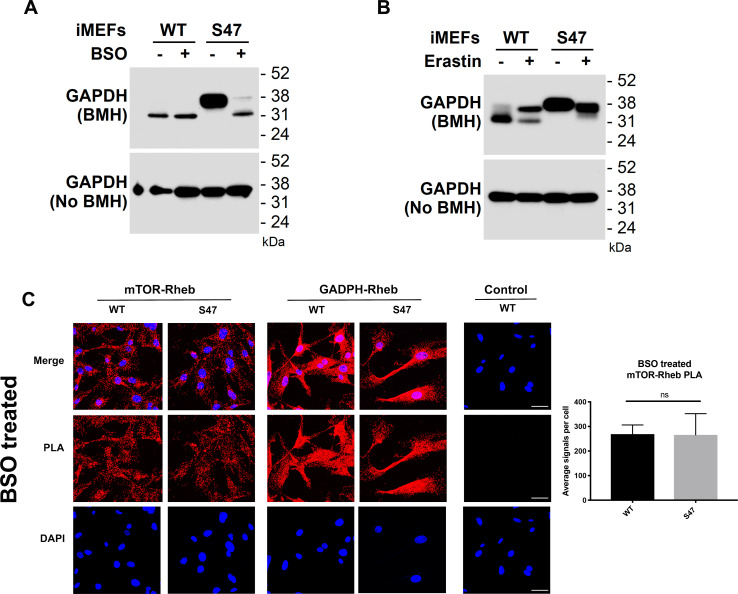
Glutathione depletion by BSO alters GAPDH cross-linking and the GAPDH-Rheb interaction.(A) WT and S47 cells were treated with PBS or 100 μM BSO for 24 hr. Lysates were prepared, treated with or without BMH, run on SDS-PAGE and detected by western blotting with a GAPDH antibody. (B) WT and S47 cells were treated with DMSO or 2 μM Erastin for 24 hr. Lysates were prepared, treated with or without BMH, resolved by SDS-PAGE, and probed by western blotting for GAPDH. (C) An in situ proximity ligation assay was performed in WT and S47 MEFs that are treated with 10 μM of BSO for 24 hr. Shown on the right is the quantification of the mTOR-Rheb interactions, measured as the average number of PLA signals per nuclei. Scale bars represent 30 µm.